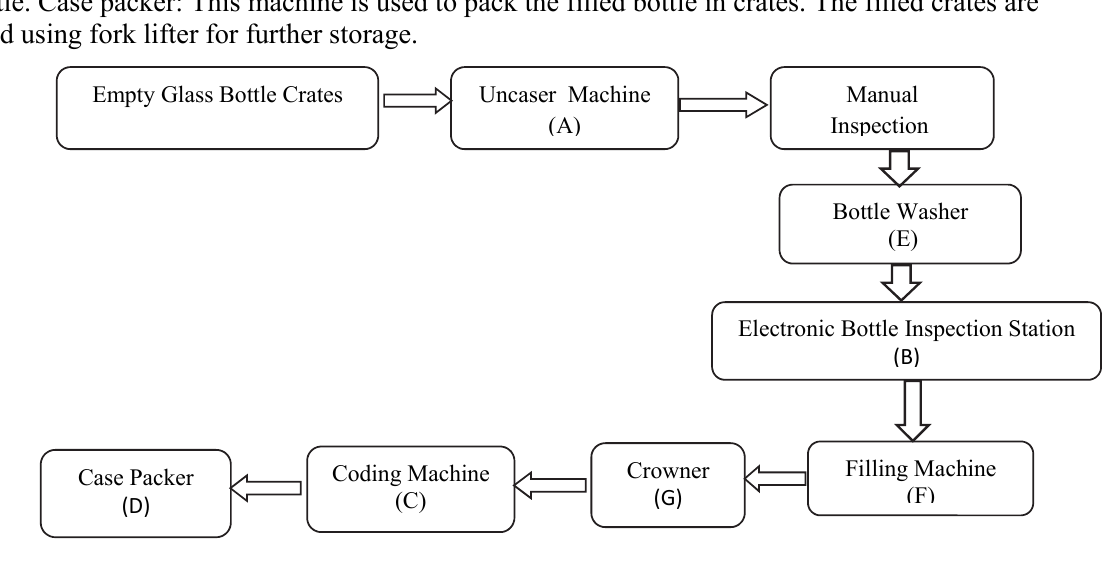
Fig. 1. Process flow diagram of CSDGB filling system of beverage